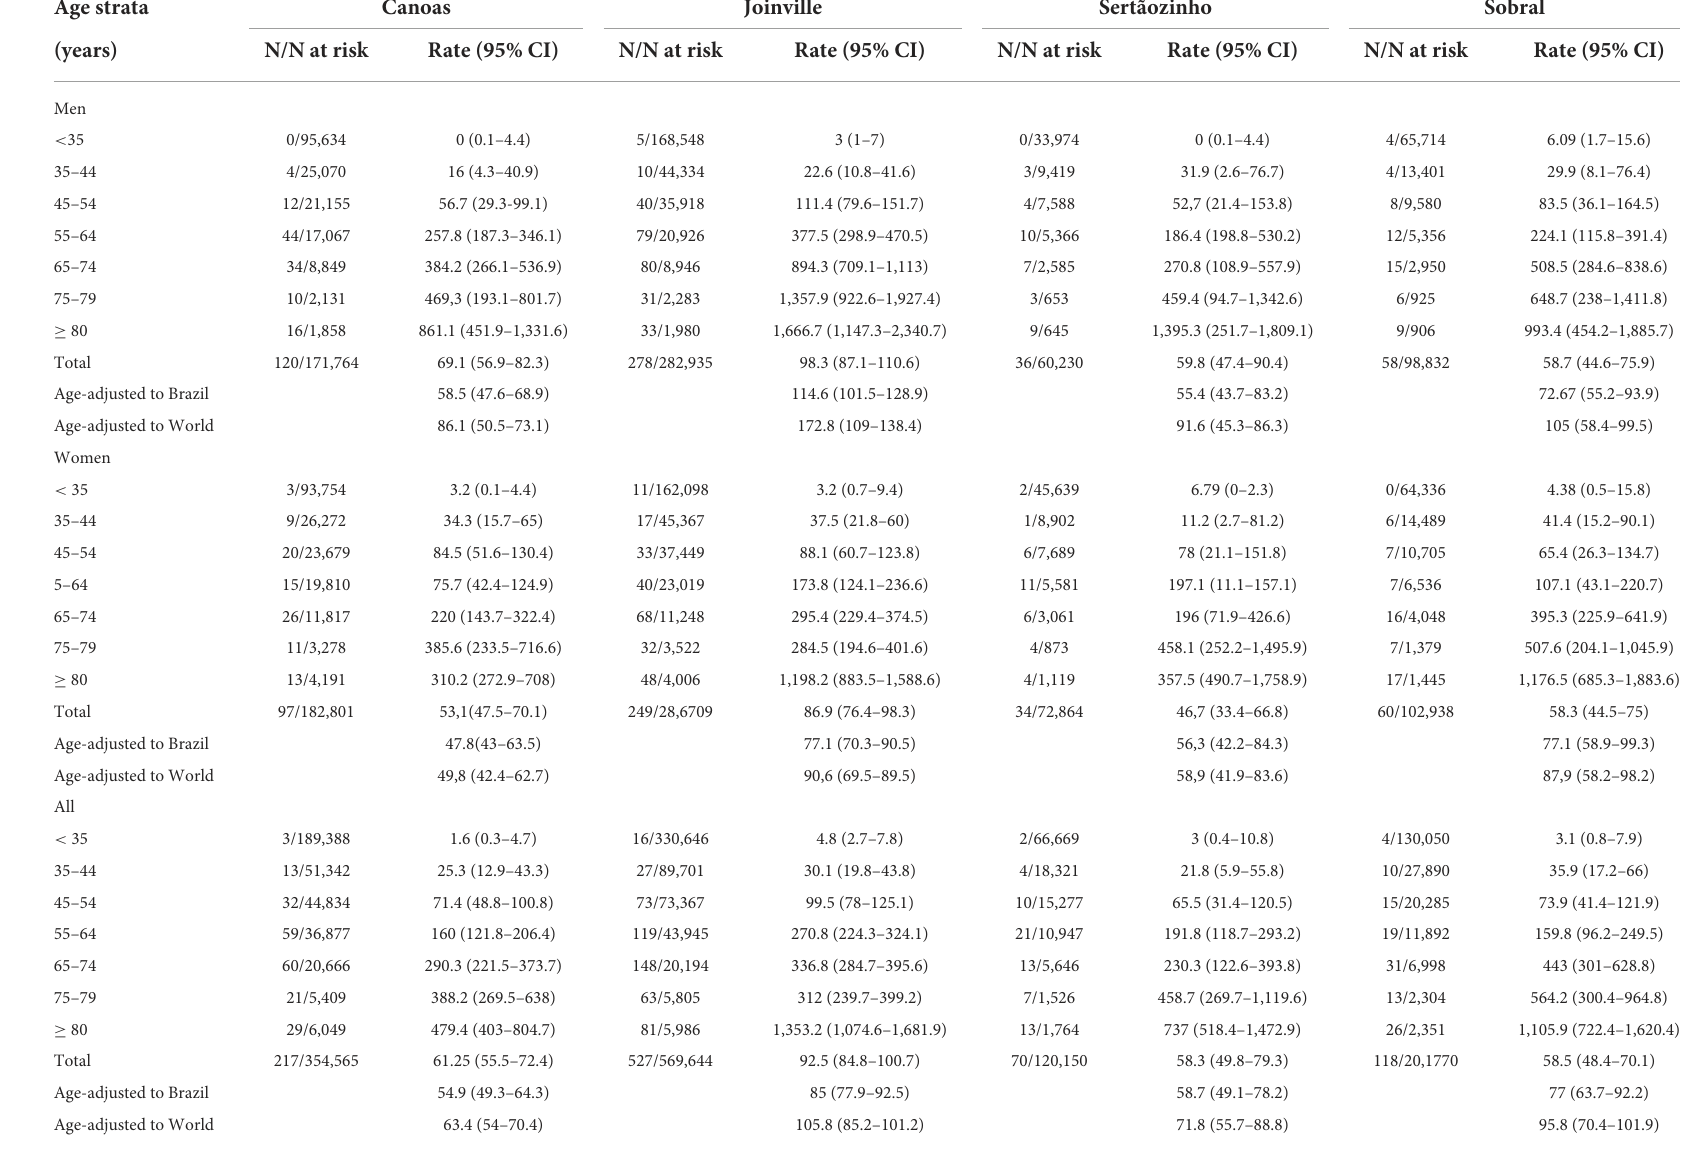
TABLE 2 Stroke incidence rates per 100,000 inhabitants according to age and sex in four Brazilian